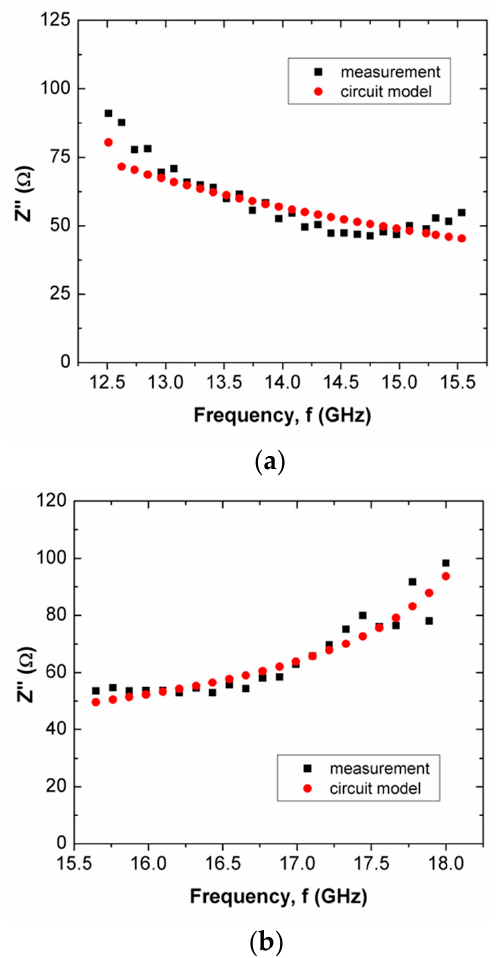
Figure 9. Measured and simulated Z”s of the scaffold composite with composition C for frequencies ( a ) <15.5 GHz and ( b ) >15.5 GHz, at Ku-band.